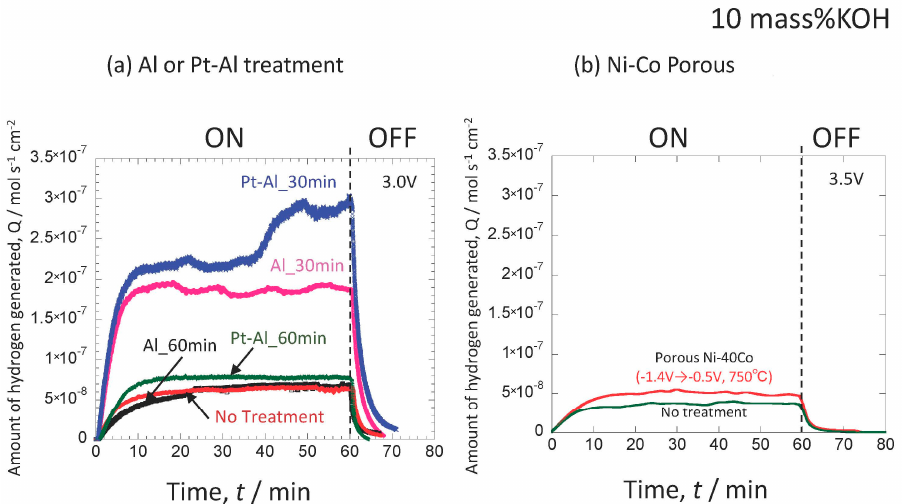
Figure 10. Time dependence of the amount of hydrogen generated measured by the oxygen pump sensor under each condition of ( a ) Al and Pt-Al porosity treatment and ( b ) Ni-Co porosity treatment [25].